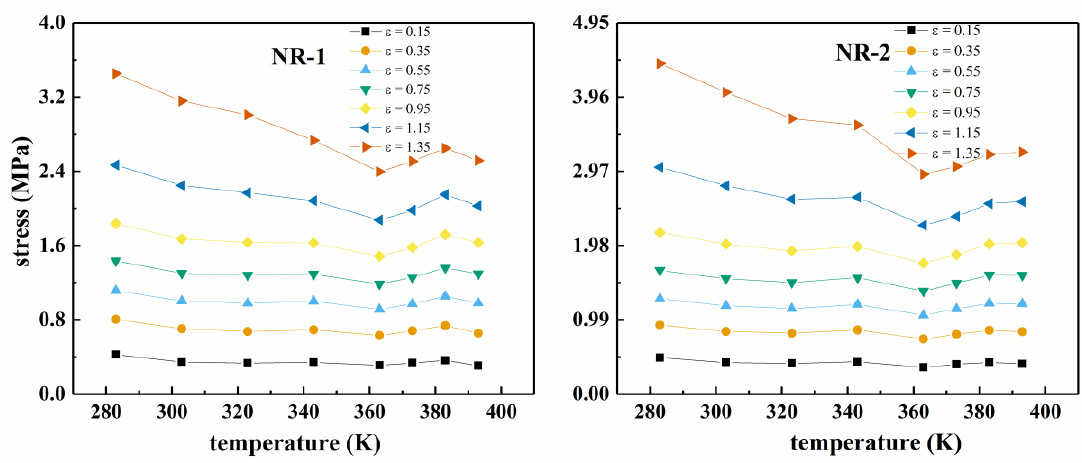
Figure 2. Stress–temperature curves at different constant strains for NR-1 and NR-2 ( ε is the value of the nominal